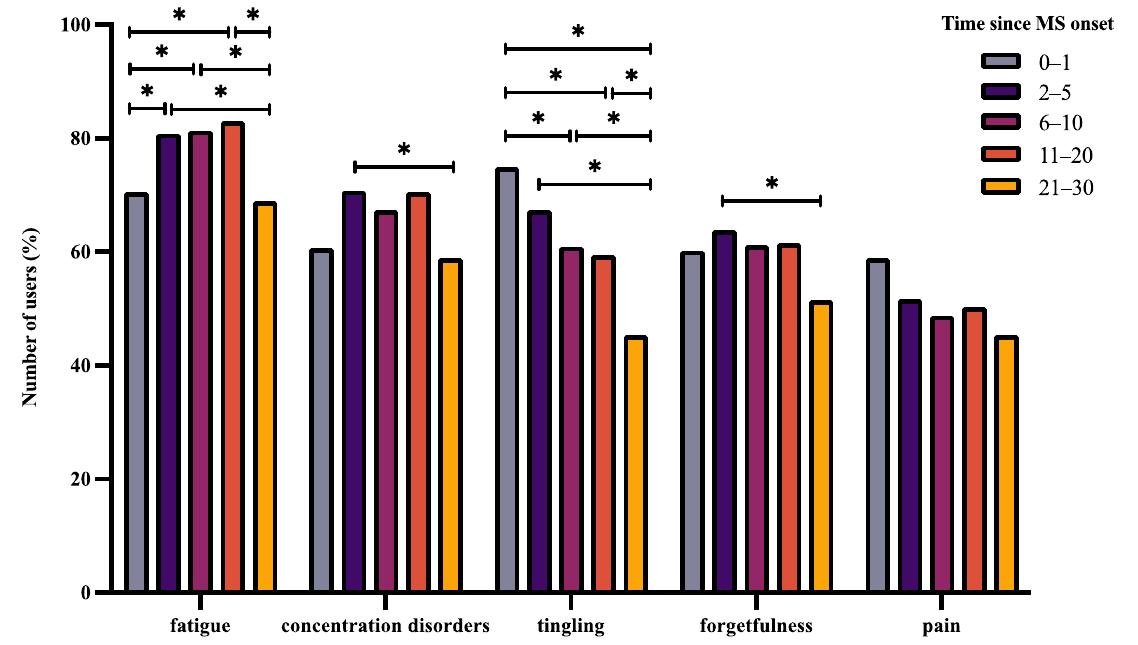
Figure 5. Distribution of the top five symptoms with time since MS diagnosis. The bar graph above shows the relative frequency of users who answered a specific symptom (normalized to the total number of unique users per time group who answered any symptom at least once, * p < 0.05, see corresponding text for exact p -values). Each user could answer or track more than one symptom.